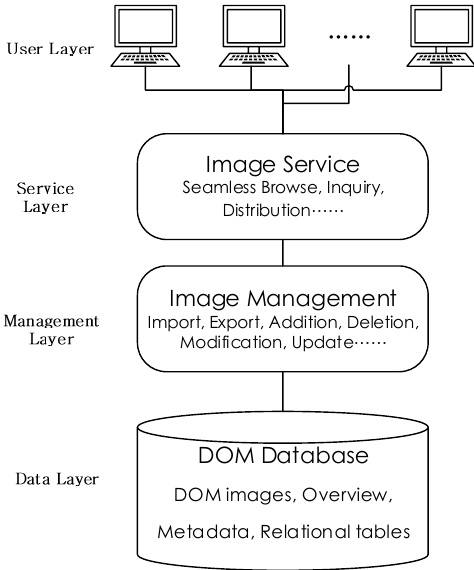
Figure 2 The logic structure chart of DOM